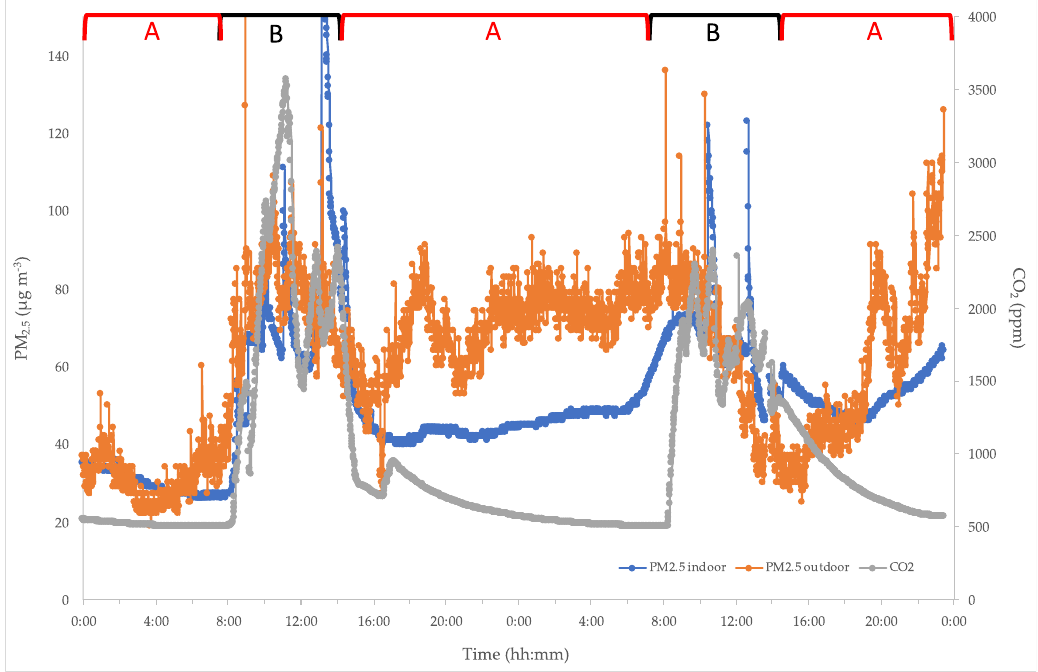
Figure 2. Indoor/outdoor PM 2.5 and CO 2 levels during 48 h-continuous measures. A : no school activity Figure 2. Indoor / outdoor PM 2.5 and CO 2 levels during 48 h-continuous measures. A : no school